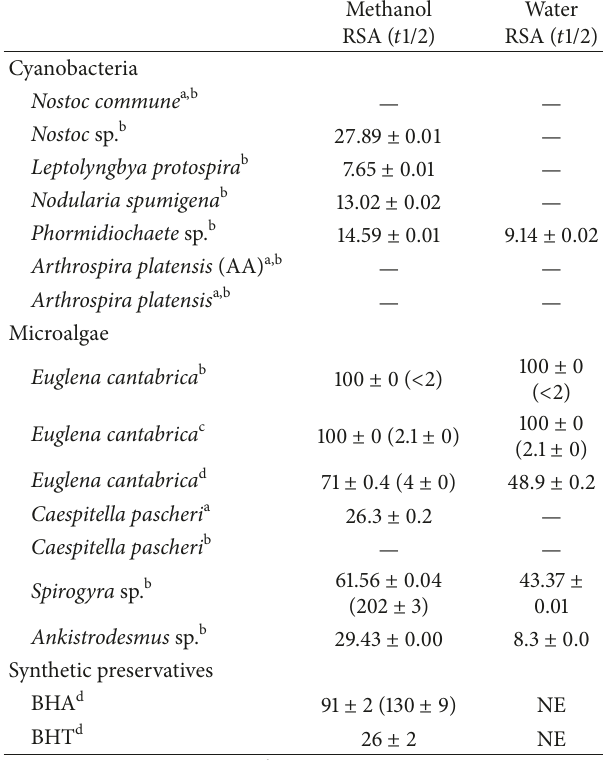
Table 3: Relative radical scavenging activity (RSA) of samples expressed as % inhibition ± standard deviation of three measure- ments and half-life ( 𝑡 1/2) in